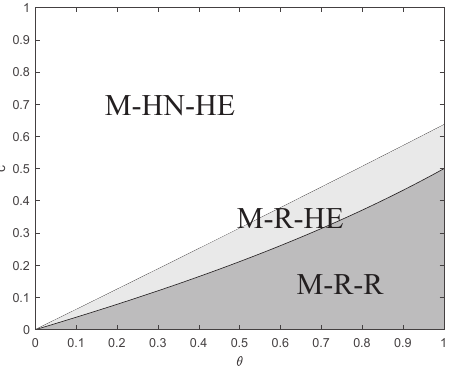
Figure 4. Optimal mode selection for manufacturers and e-commerce